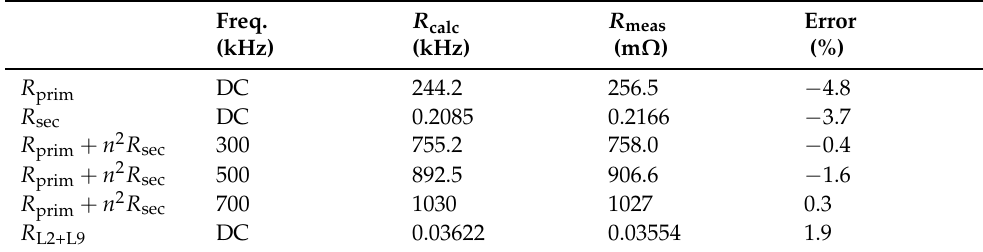
Figure 7. ( a ) Radii calculated from (10) for minimizing winding resistance. ( b ) Transformer AC- to-DC resistance ratio across frequency—measured as shown in ( c )—with secondary-side short- circuited for two copper-thickness arrangements: 70µm primary (HV) and 70µm secondary-side (LV) windings, or 70µm HV and 270µm LV windings (with 0.2mm copper foils soldered onto the 70µm LV windings for experimental results). ( c ) Measurement technique for transformer resistance measurements, with measurement opens and shorts highlighted at right. Table 3. Comparison between predicted and measured winding losses for the PCB-integrated transformer. All parameters at T = 25°C.